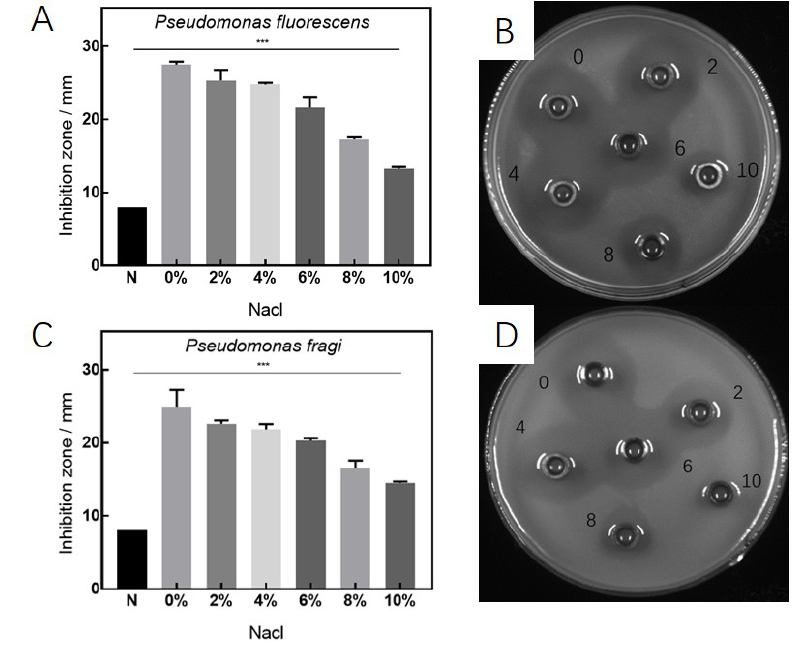
Figure 6. Antibacterial effects under different salinities of D. algida on the target Pseudomonas ,